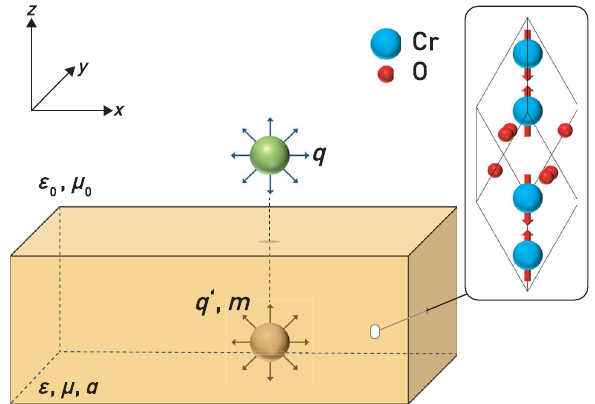
FIG. 1. A charge q (green sphere) above the surface of a magnetoelectric induces an image monopole m (brown sphere) at the same distance beneath the surface. The magnetic field above the surface is divergent with its source at the subsurface image monopole. The enlargement shows the unit cell of the proto- typical magnetoelectric Cr 2 O 3